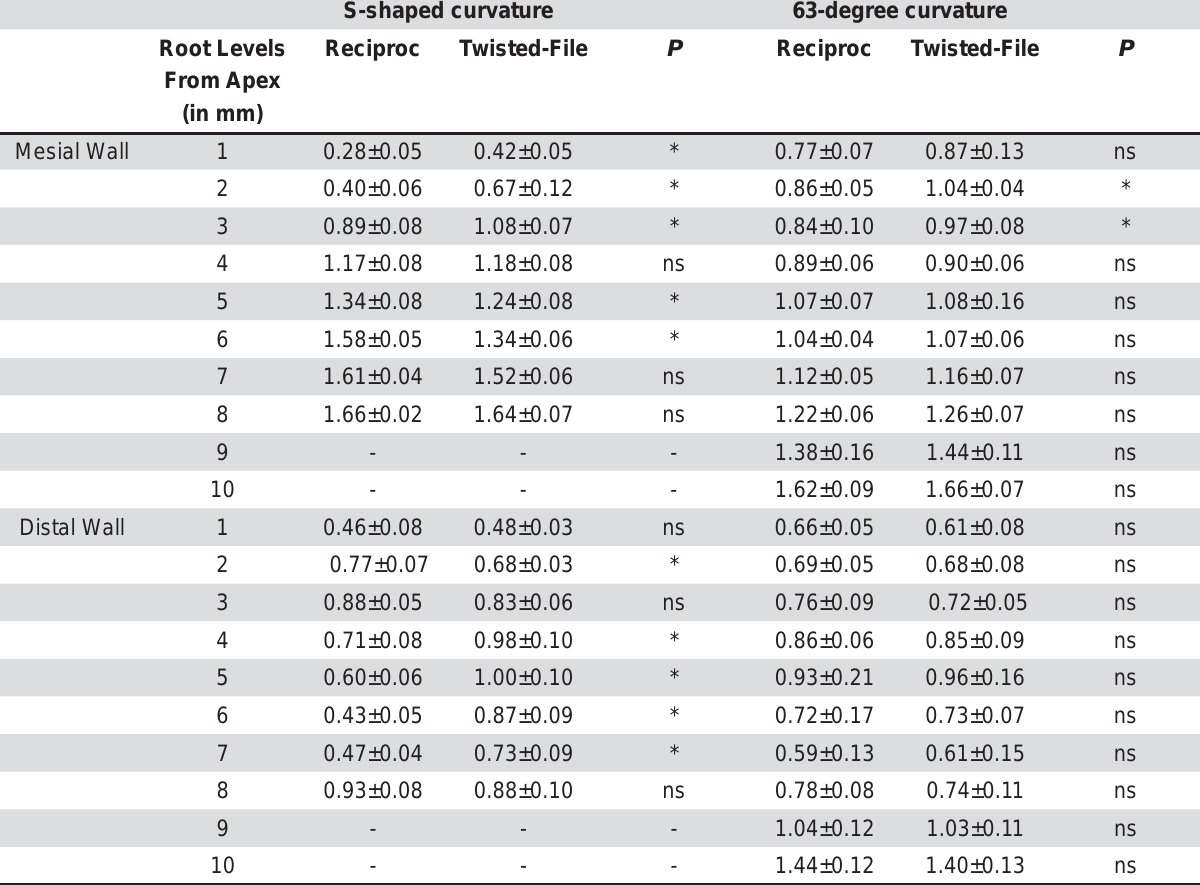
Table 1- Mean and standard deviation of the amount of resin thickness at the mesial and distal walls of the mesial root of both prototyping molar replicas, in different levels, after root canal preparation with Reciproc and Twisted-File Adaptive